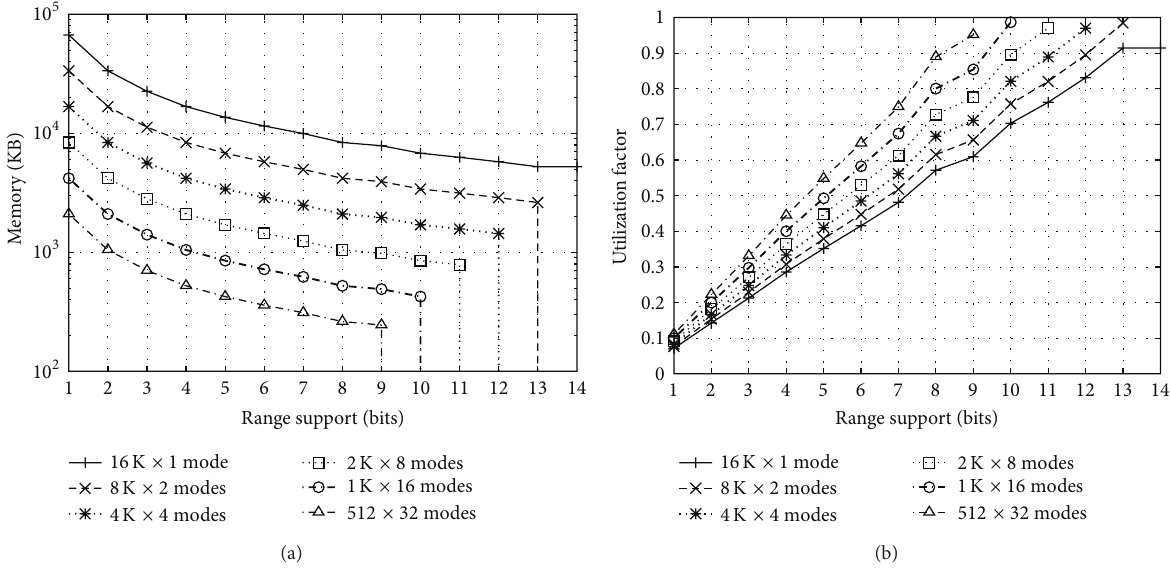
Figure 18: Range support through BRAM modes: (a) memory footprint and (b) utilization